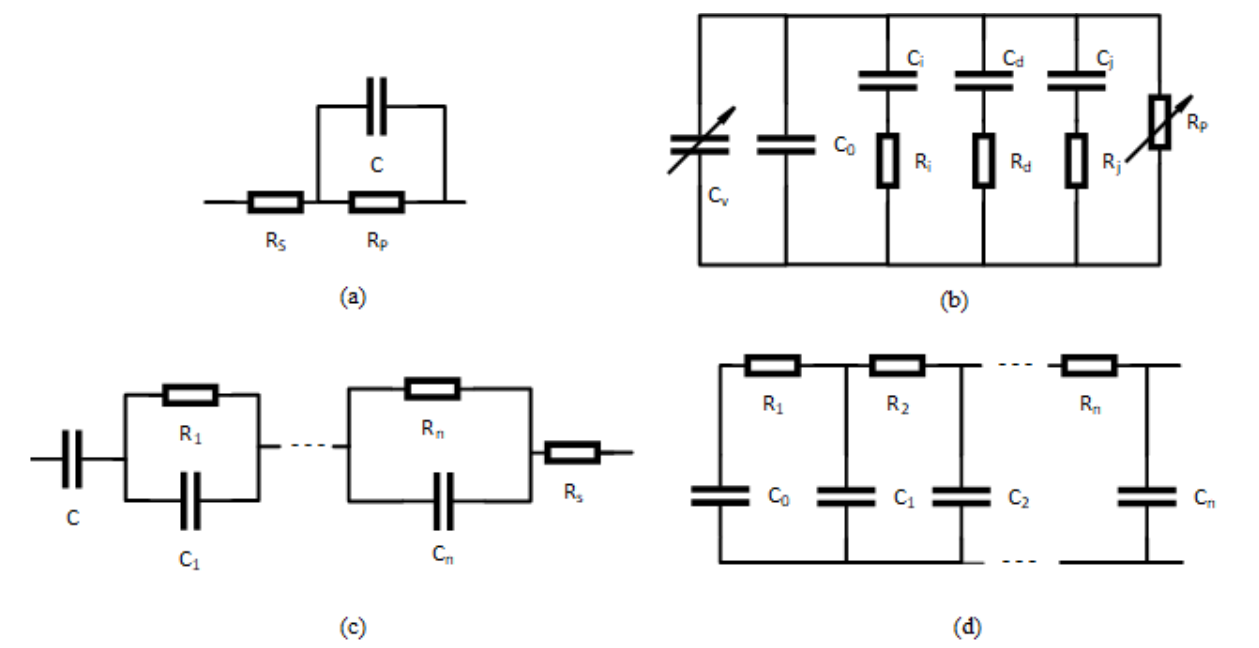
Figure 4. Supercapacitor equivalent circuit models [19,23,24,26]. (a): Simplified model, (b) Zubieta and Boner developed model, (c) modified version of Zubieta and Boner developed model, (d) Transmission line model .